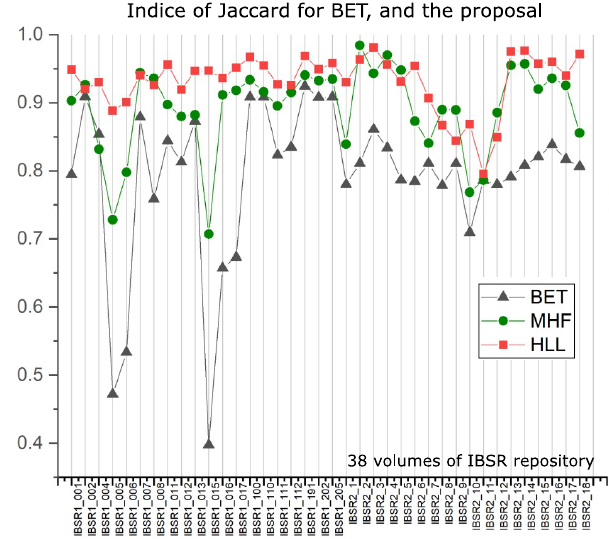
Figure 15. Indices of Dice and Jaccard to compare procedures BET, MHF, and HLL. Figures 8 and 9 show diagrams corresponding to MHF and HLL